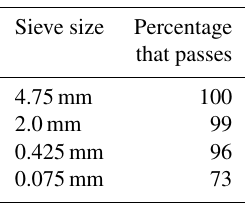
Table 2. Percentage that passes through